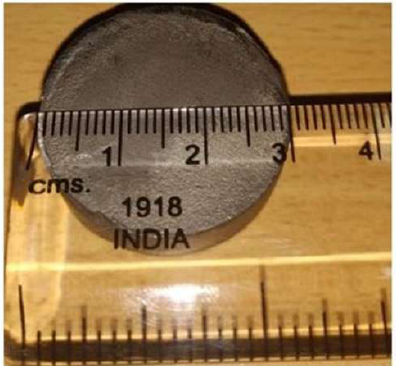
Figure 2. Schematic representation of vacuum hot pressed sample.